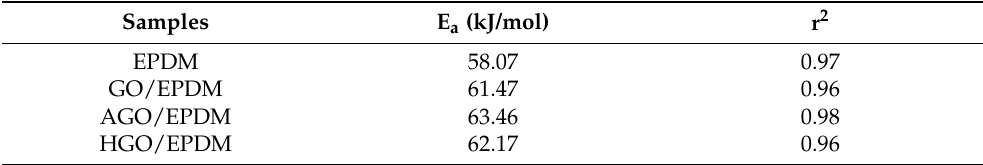
Table 3. Migration activation energy in different